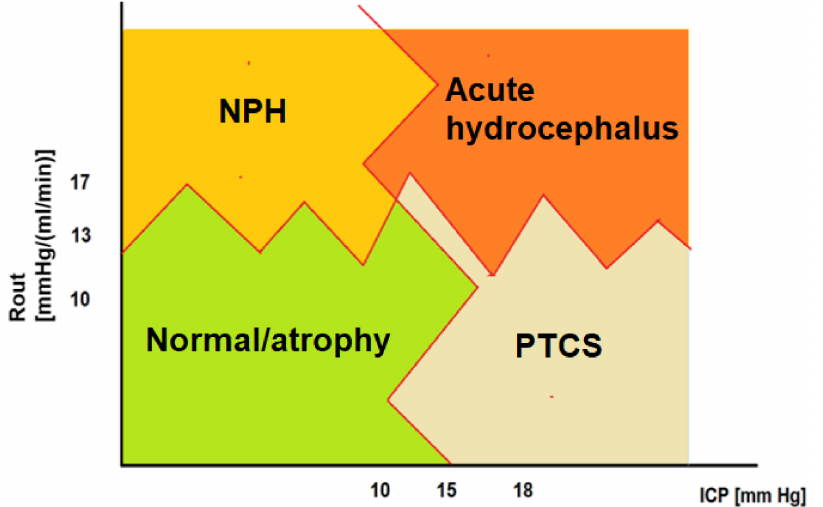
Figure 5. Classification of CSF disorders based on ICP baseline and Resistance to CSF outflow. Rout along the y-axis is plotted against ICP baseline. Using Rout thresholds and ICP thresholds, we have generated four quadrants, separated from each other via irregular borders to reflect the grey areas yet to be elucidated. Normal patients, and in extremes, atrophic brains tend to have ICP < 15 mmHg and Rout < 13 (even lower in atrophy or intracranial hypotension). NPH should show ICP < 15 and in- creased Rout above 13–17 mmHg*(min/mL). Acute hydrocephalus has both high ICP and high Rout. For completion, PTCS (or idiopathic intracranial hypertension) is shown as a disorder with high base- line ICP but normal or low Rout. (Figure modified from M. Czosnyka, 30 Lectures on Brain Physics, https://www.neurosurg.cam.ac.uk/research-groups/brain-physics-lab/brain-physics-lectures-20 20/?fbclid=IwAR0A6Yh-NqAheMO7GHi2HHD-Bug5mgSyhK7nWM1uG729wbt4a6XNqOzFZQ4; accessed on 21 March